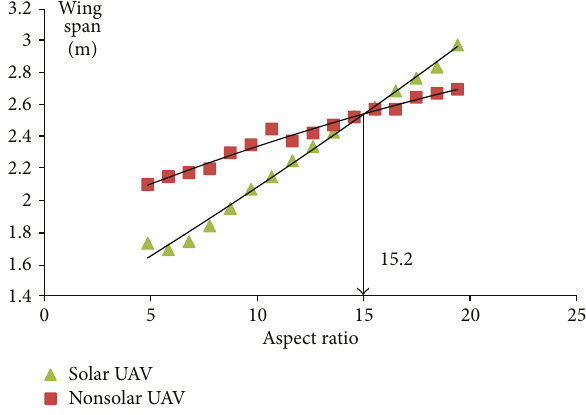
Figure 5: Aspect ratio versus wing span of the solar and nonsolar UAVs at 0.35kg payload.